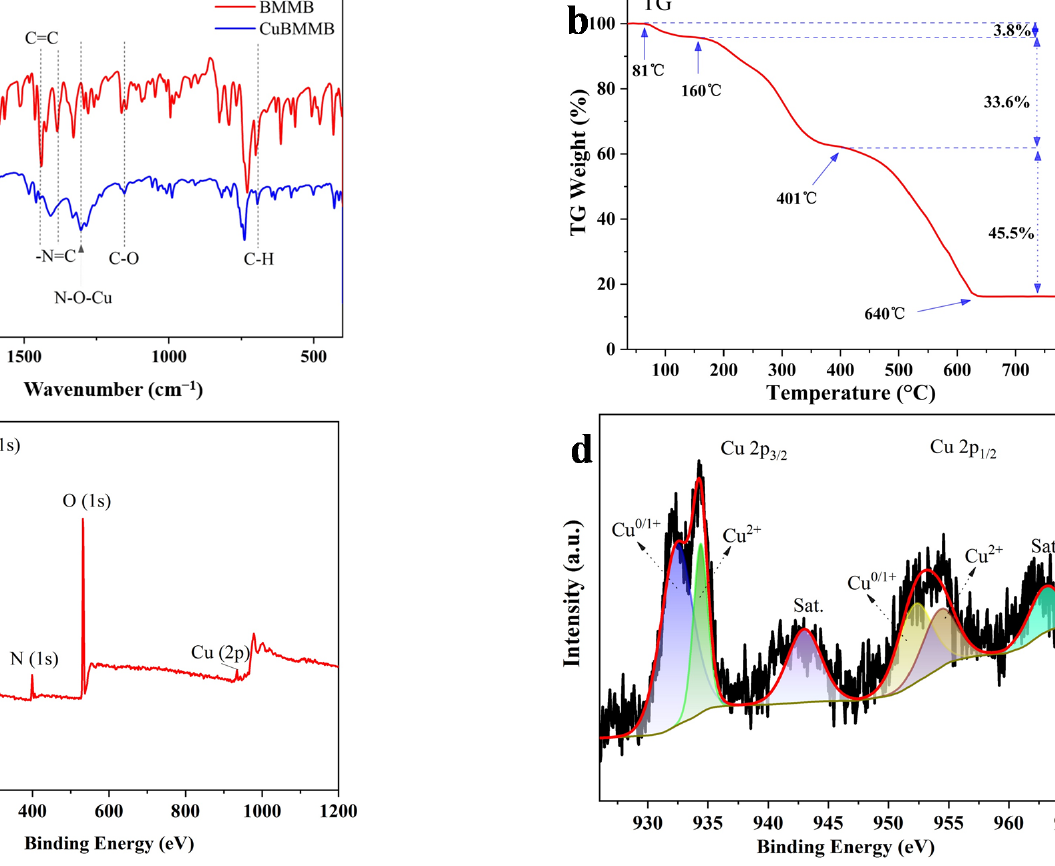
Figure 3. ( a ) FT-IR; ( b ) TG spectra of CuBMMB; and XPS survey of ( c ) CuBMMB and ( d ) Cu 2p.